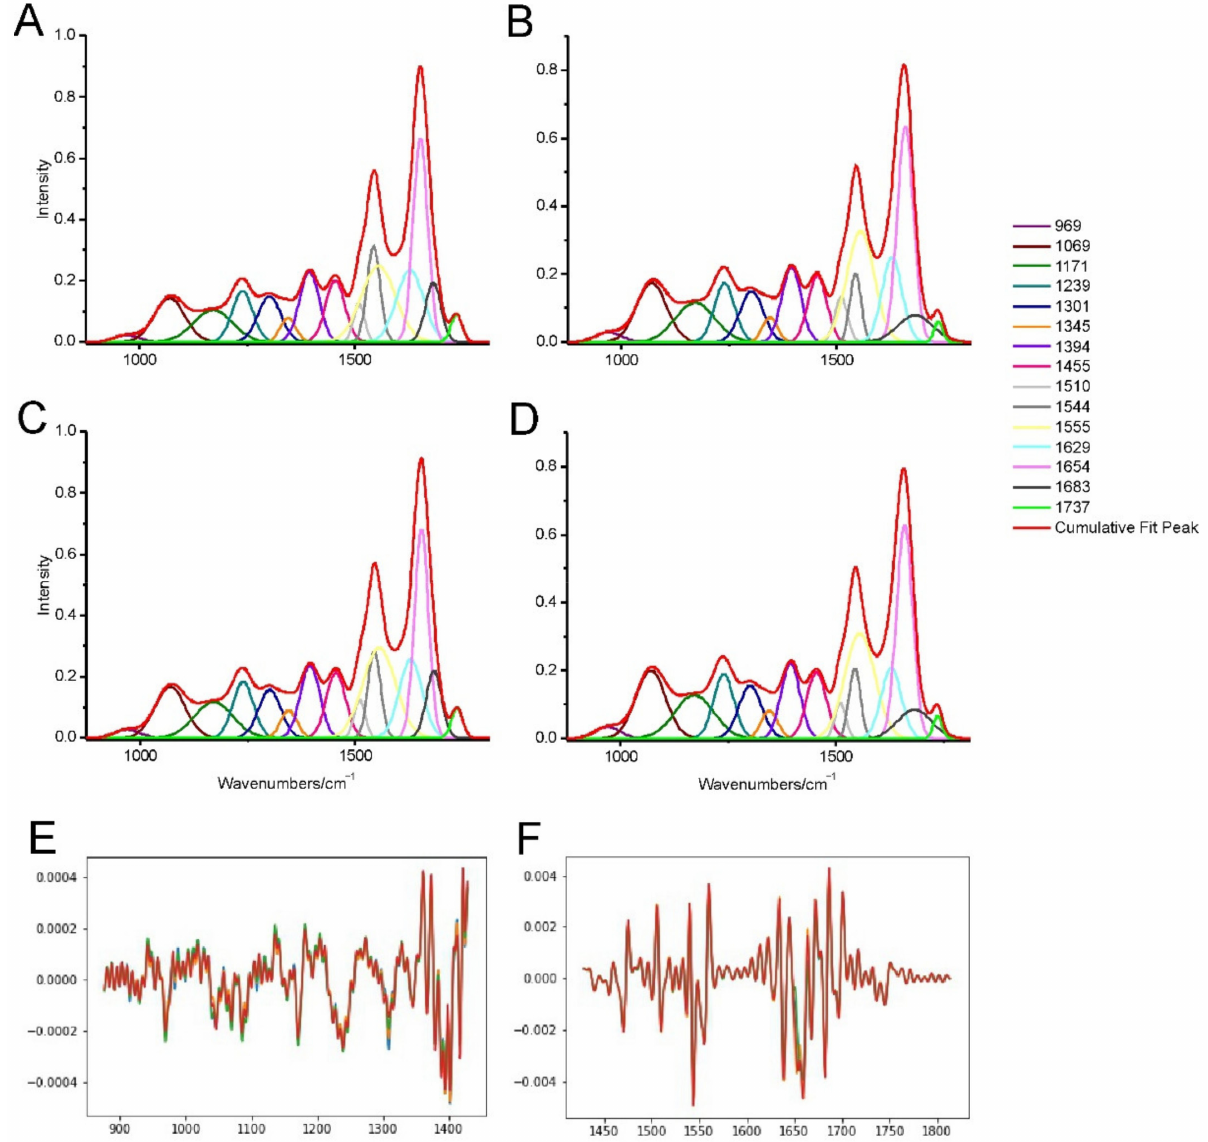
Figure 3. The deconvoluted and second derivative spectra of the protein (region A) and lipid region (region B) in the 1780–900 cm − 1 . The protein region is in the 1717–1485 cm − 1 . The lipid region is split into 1770–1718 cm − 1 and 1275–996 cm − 1 : ( A ) hippocampus spectra of the control sample. ( B ) hippocampus spectra of the TP-315 treated sample. ( C ) cerebral cortex spectra of the control sample. ( D ) cerebral cortex spectra of the TP-315 treated sample. ( E ) second derivative spectra in the 1428–876 cm − 1 range of control mouse hippocampus (orange spectrum), hippocampus of the treated mouse (blue spectrum), cerebral cortex of the control mouse (red spectrum) and cerebral cortex of the treated mouse (green spectrum). ( F ) second derivative spectra in the 1814–1428 cm − 1 range of control mouse hippocampus (orange spectrum), hippocampus of the treated mouse (blue spectrum), cerebral cortex of the control mouse (red spectrum) and cerebral cortex of the treated mouse (green spectrum). The bands are described in Table